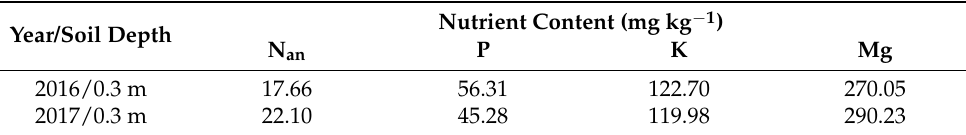
Table 1. Nutrients content in soil after analysis in autumn. Year/Soil